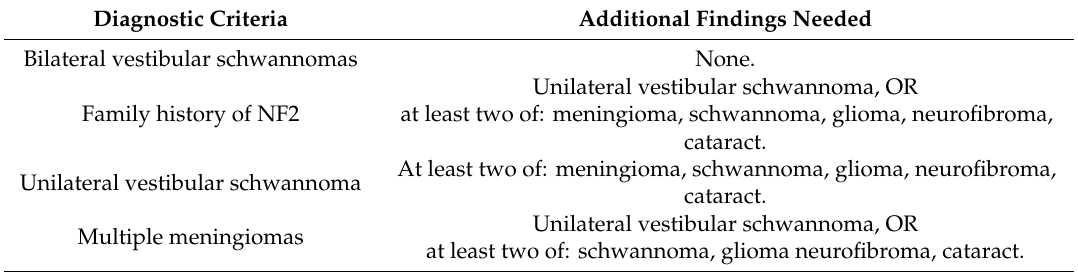
Table 1. Manchester clinical diagnostic criteria for neurofibromatosis type 2